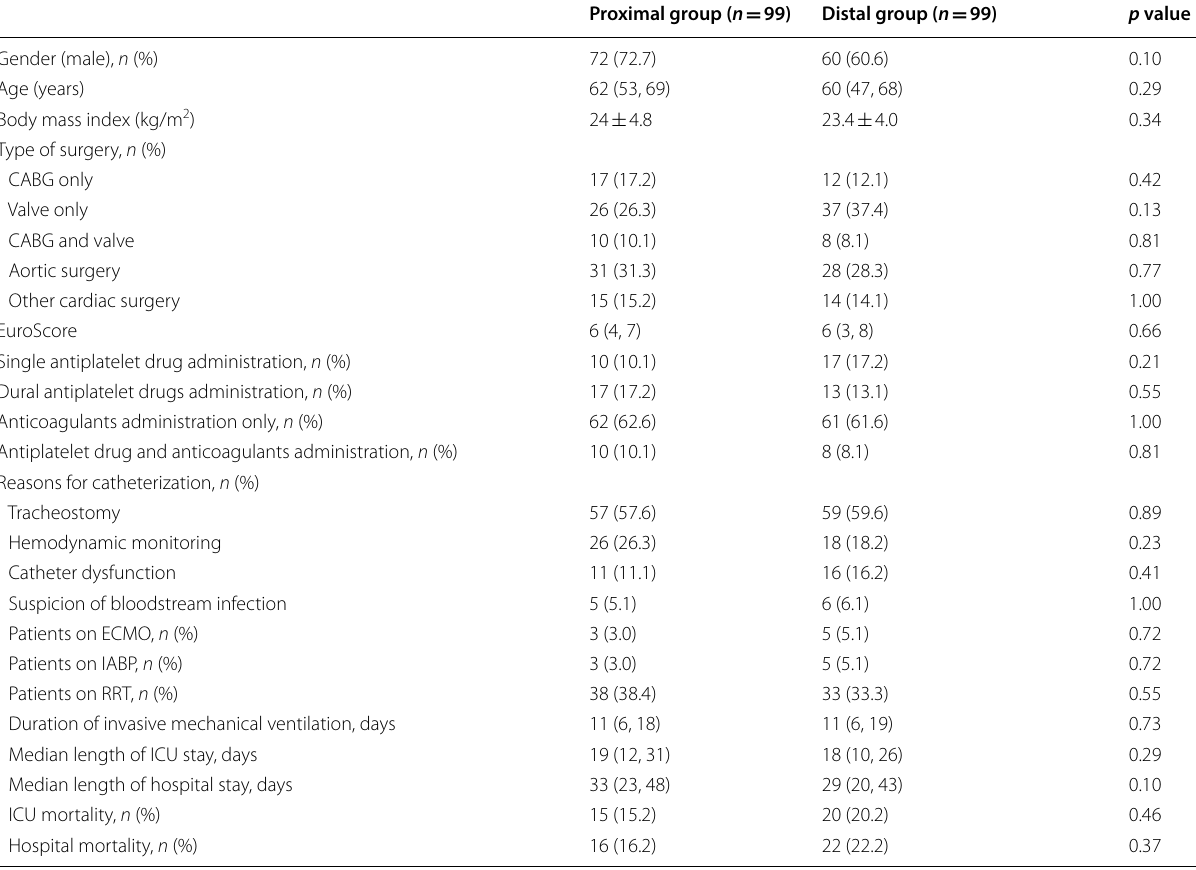
Table 1 Baseline clinical parameters of the study